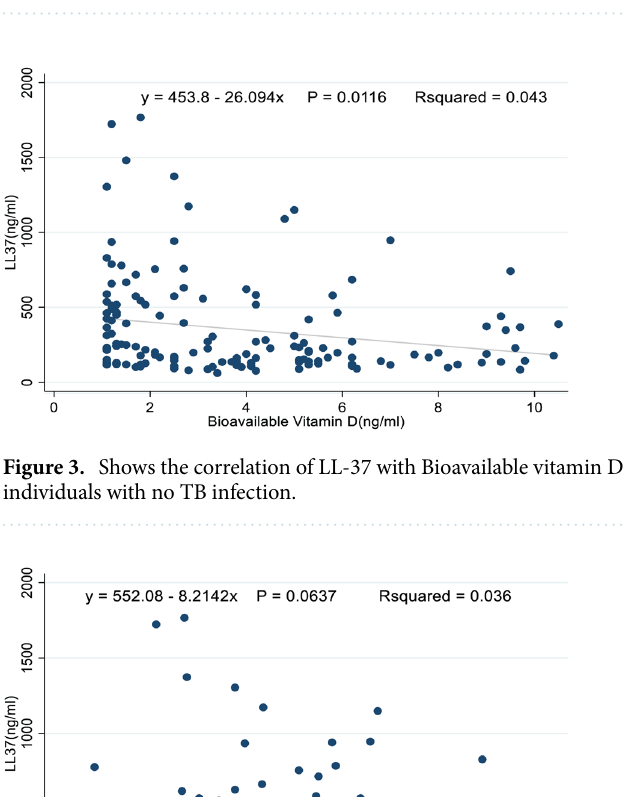
Figure 2. Comparison of serum LL-37 levels among ATB patients, LTBI individuals, and individuals with no TB infection. Median serum concentrations were significantly higher among the ATB patients compared to the LTBI and those with no TB infection.